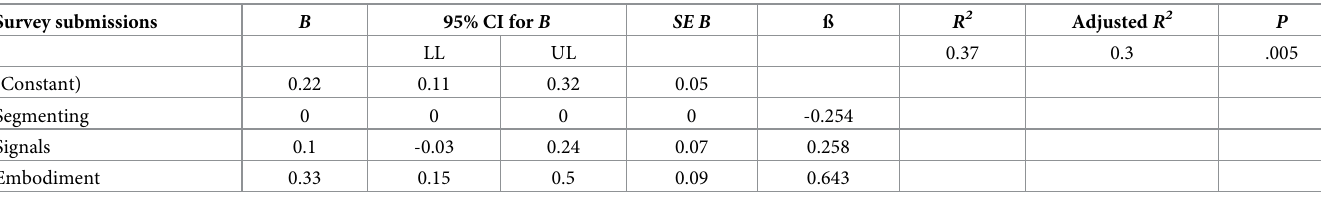
Table 3. Multiple regression results for the number of survey